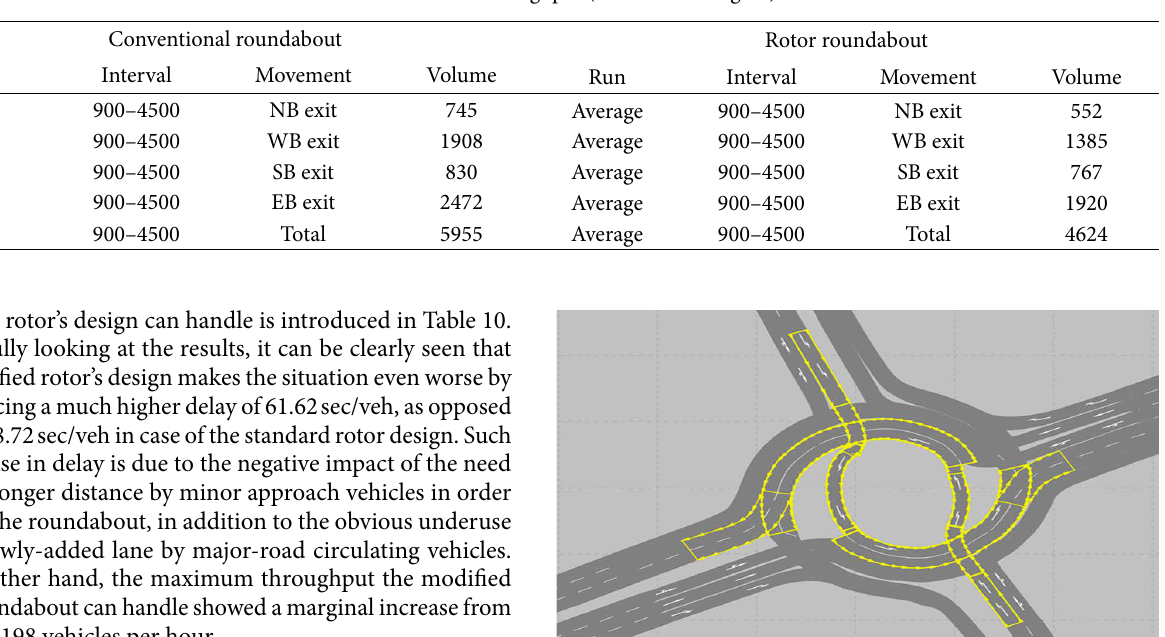
Table 12: Maximum throughput (alternative design